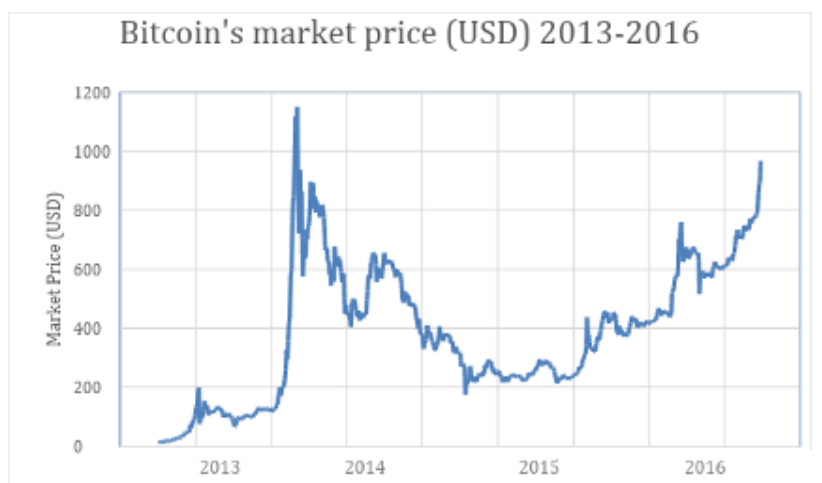
Figure 2: Bitcoin’s market price 2013–2016 (source: Own elaboration based on data collected on blockchain.info)